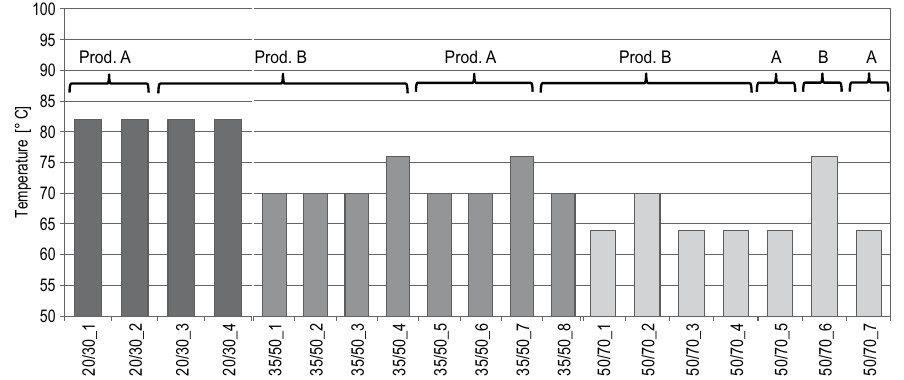
Fig. 7. Upper limit of the performance grade temperature for unmodified bitumen